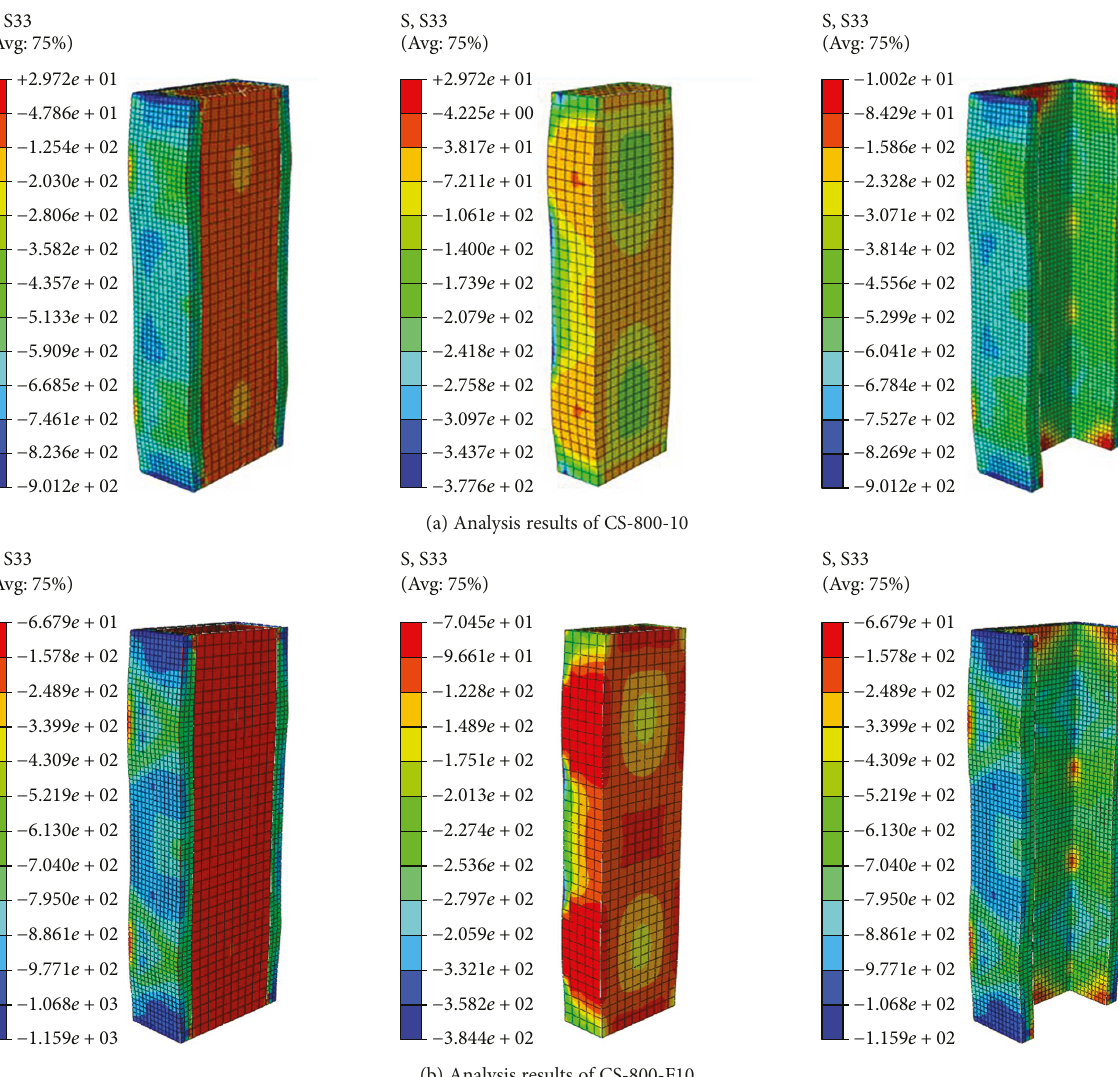
Figure 11: Failure aspect of SFRC- fi lled high-strength steel tube